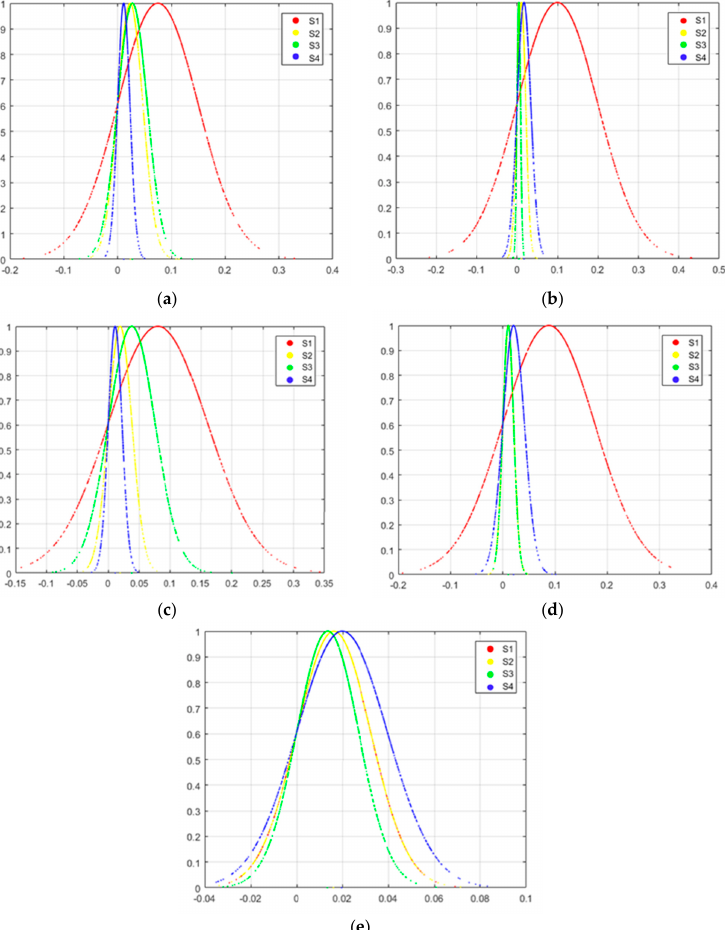
Figure 6. Cloud map of normal cloud model under the weight of each group of indicators. ( a ) Cloud map under the first set of weights; ( b ) Cloud map under the second set of weights; ( c ) Cloud map under the third set of weights; ( d ) Cloud map under the fourth set of weights; ( e ) Cloud map under the fifth set of weights.